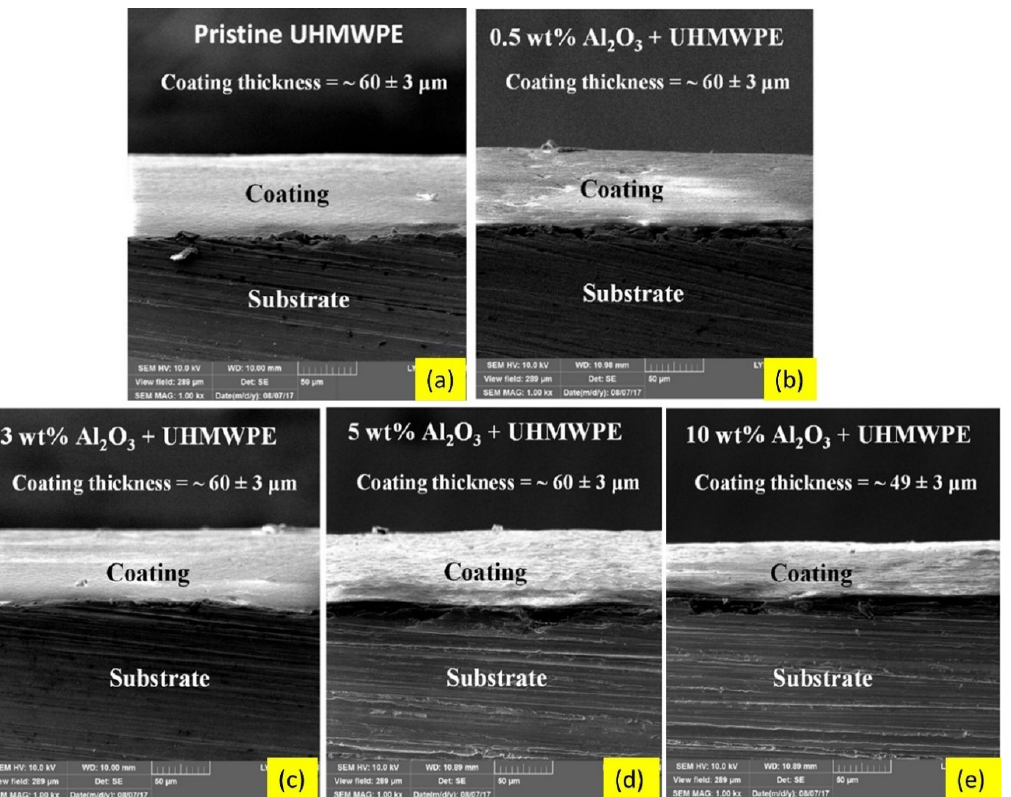
Figure 13. FESEM cross-sectional images of the UHMWPE coating/steel substrate system for the ( a )pristine, ( b ) UHMWPE with 0.5 wt % Al 2 O 3, ( c ) UHMWPE with 3 wt % Al 2 O 3 , ( d ) UHMWPE with